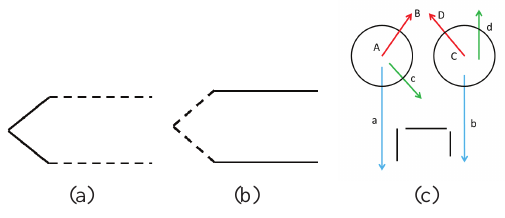
Figure 2: Illustration of ship models: (a) the “V” ship head model; (b) the “ || ” ship body model; (c) the ship model candidates.